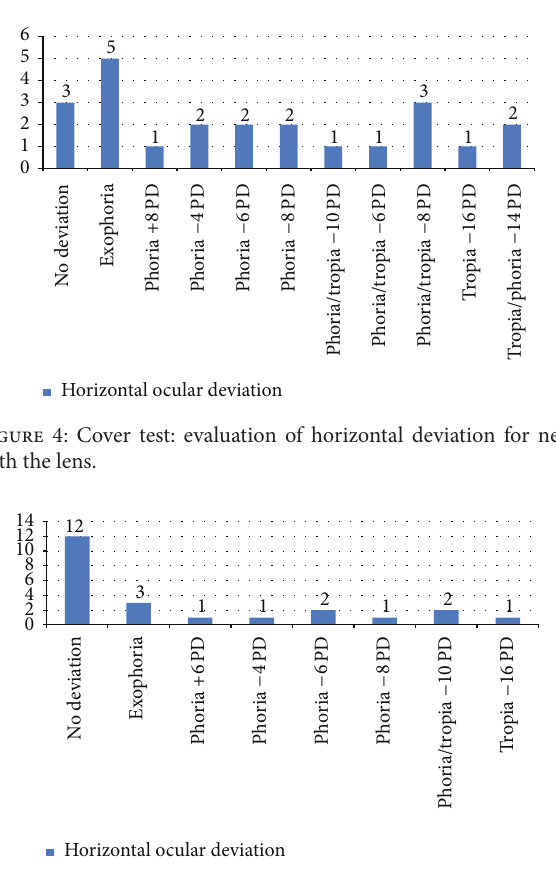
Figure 5: Cover test: evaluation of the horizontal deviation for near without